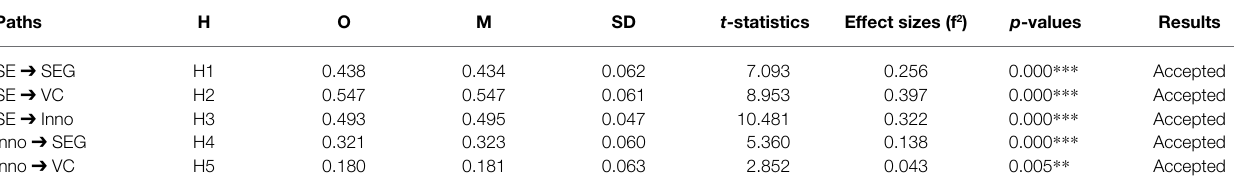
TABLE 6 | Direct effects of the